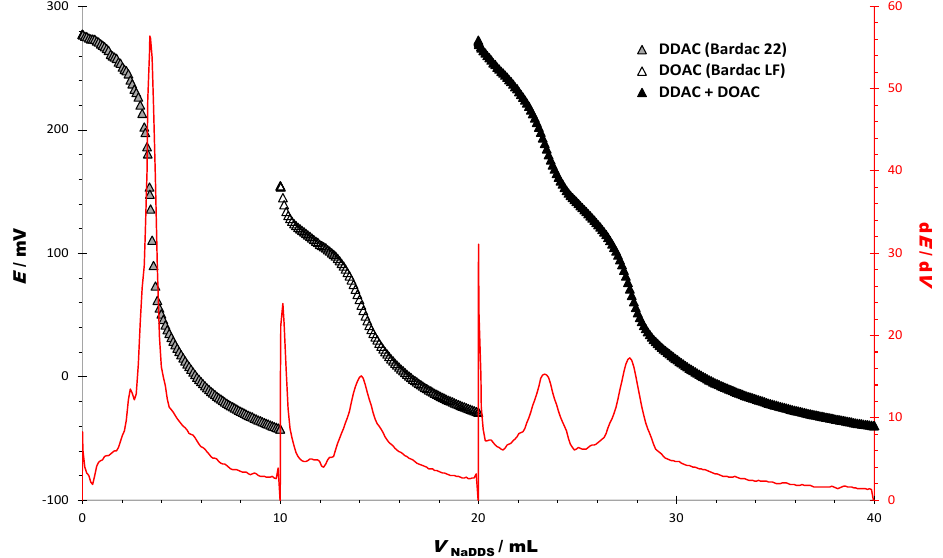
Figure 2. Potentiometric titration curves and their first derivatives of DDAC, DOAC, and the two- component model mixture of DDAC and DOAC [1:1 ( w / w )], using SDS as titrant ( c = 4 mM) and DODI - TPB potentiometric sensor as an indicator.